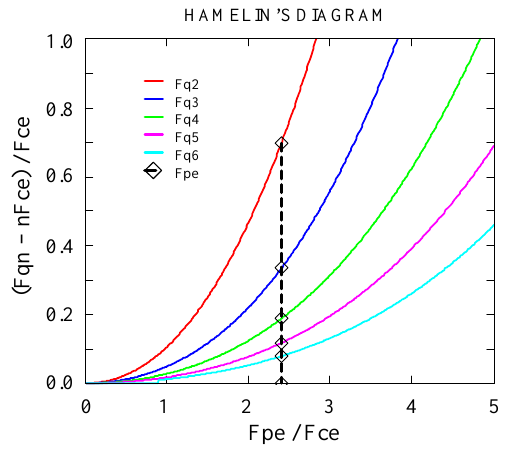
Fig. 4. Frequency positions of five of the Bernstein’s mode reso- nances, from F q 2 to F q 6. The frequency separation between a F qn and the harmonic of the electron cyclotron frequency, nF ce , that is just below F qn , is plotted as a function of the plasma frequency, F pe . For convenience, this separation and F pe are normalized to F ce . The diamonds aligned on a vertical line give the F qn frequen- cies expected for a Maxwellian plasma with a given F pe